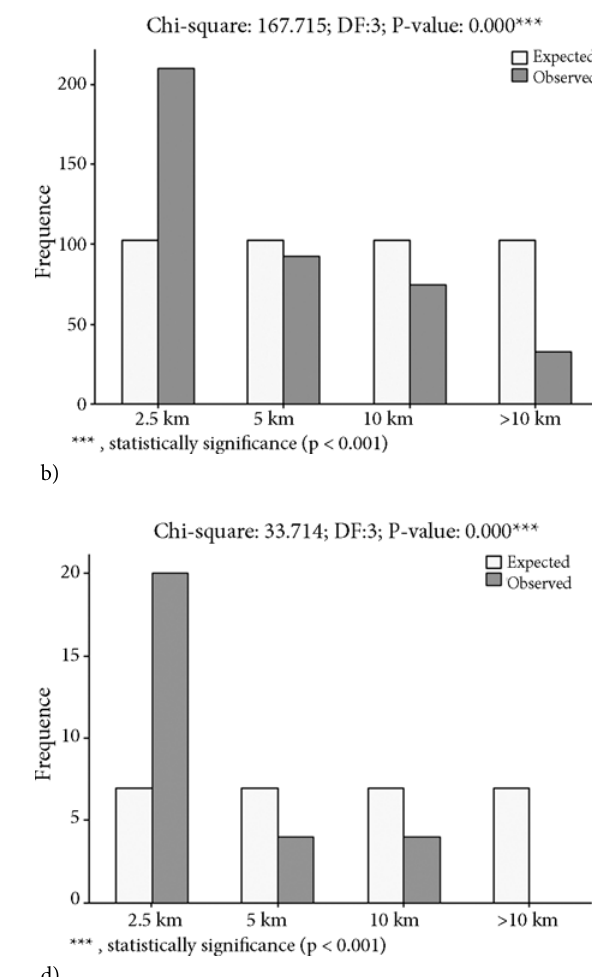
a) b) Fig. 5. Number of provinces and counties according to distances: a) number of counties with no coast to big water masses to distances; b) number of counties with coast to big water masses to distances; c) number of provinces with no coast to big water masses to distances; d) number of provinces with coast to big water masses to distances